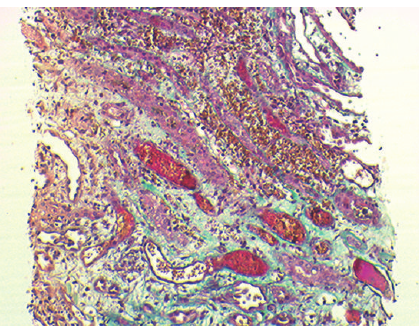
Figure 2: Interstitial hemorrhage (Masson’s trichrome, magnifica- tion 100x).